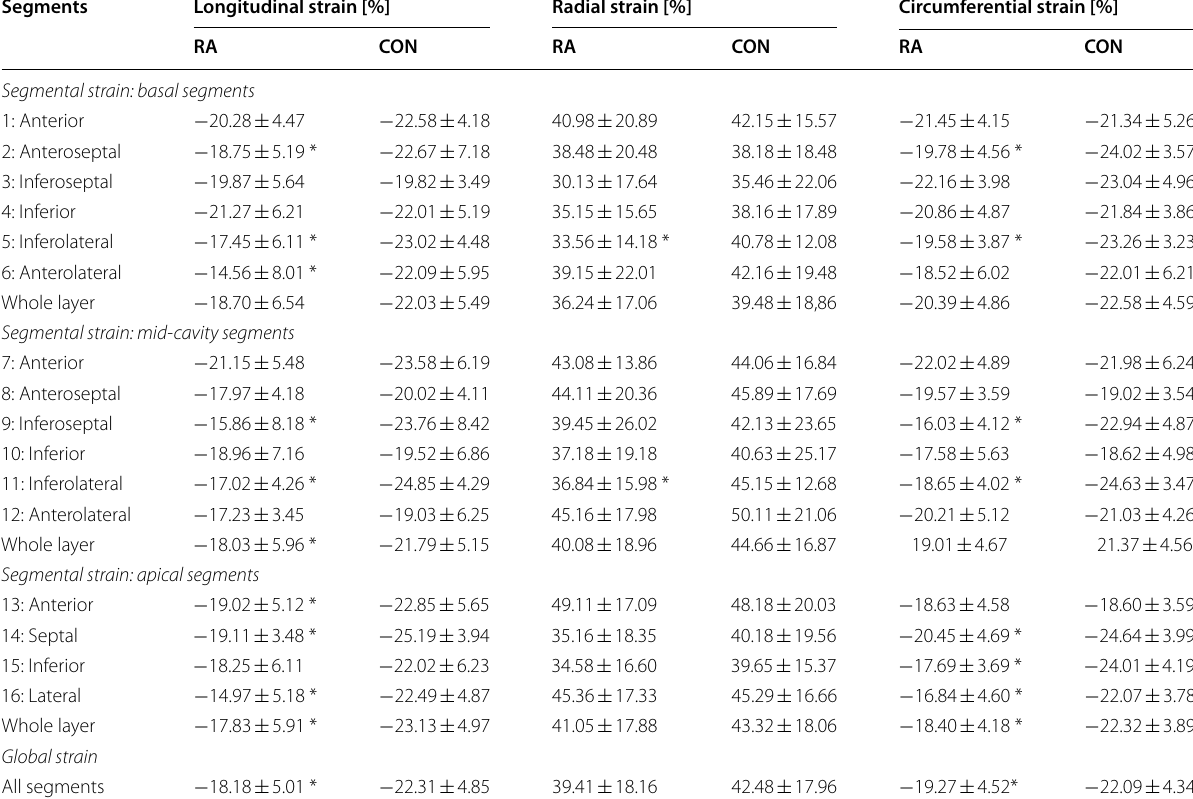
Table 4 Parameters of left ventricular myocardial strain assessed by cardiac magnetic resonance feature tracking in the study groups of patients